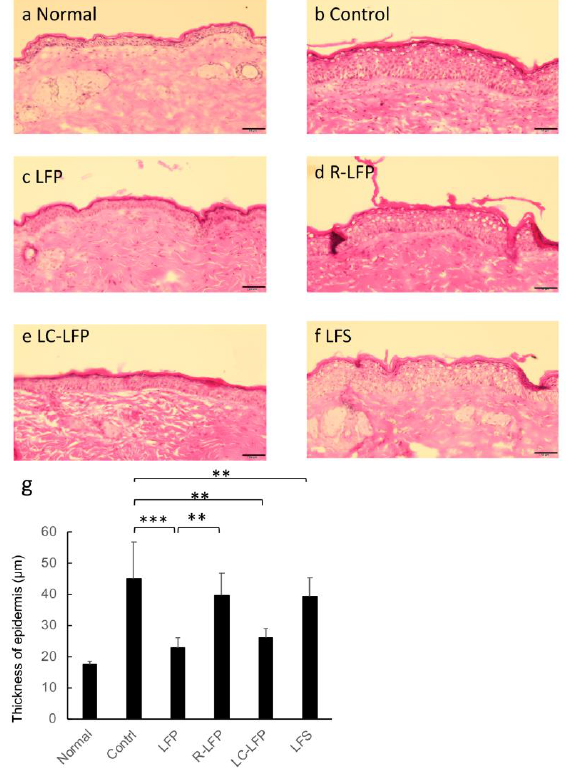
Figure 6. ( a – g ) Histological images of skin sections from regular and HR-AD-fed mice after oral administration of lactic acid bacteria metabolites for 40 days. Skin samples were fixed with 10% formalin in PBS, sectioned, and stained with hematoxylin and eosin. ( g ) Quantification of the thickness of the epidermis after 40 days. ** p < 0.01, *** p < 0.001 (Tukey’s post-hoc test). Groups: normal (regular diet fed, distilled water), control (HR-AD fed, 10.8% ethanol in water), lactic fermentation products (HR-AD fed, LFP), residue of LFP (HR-AD fed, LFP), lipid components of LFP (HR-AD fed, LC-LFP) and lactic fermentation secretion (HR-AD fed, LFS) groups. Scale bar represents 50 µ